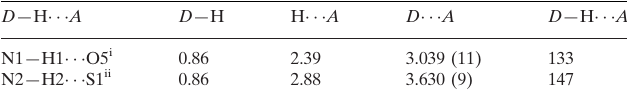
Hydrogen-bond geometry (A˚ , (cid:2)